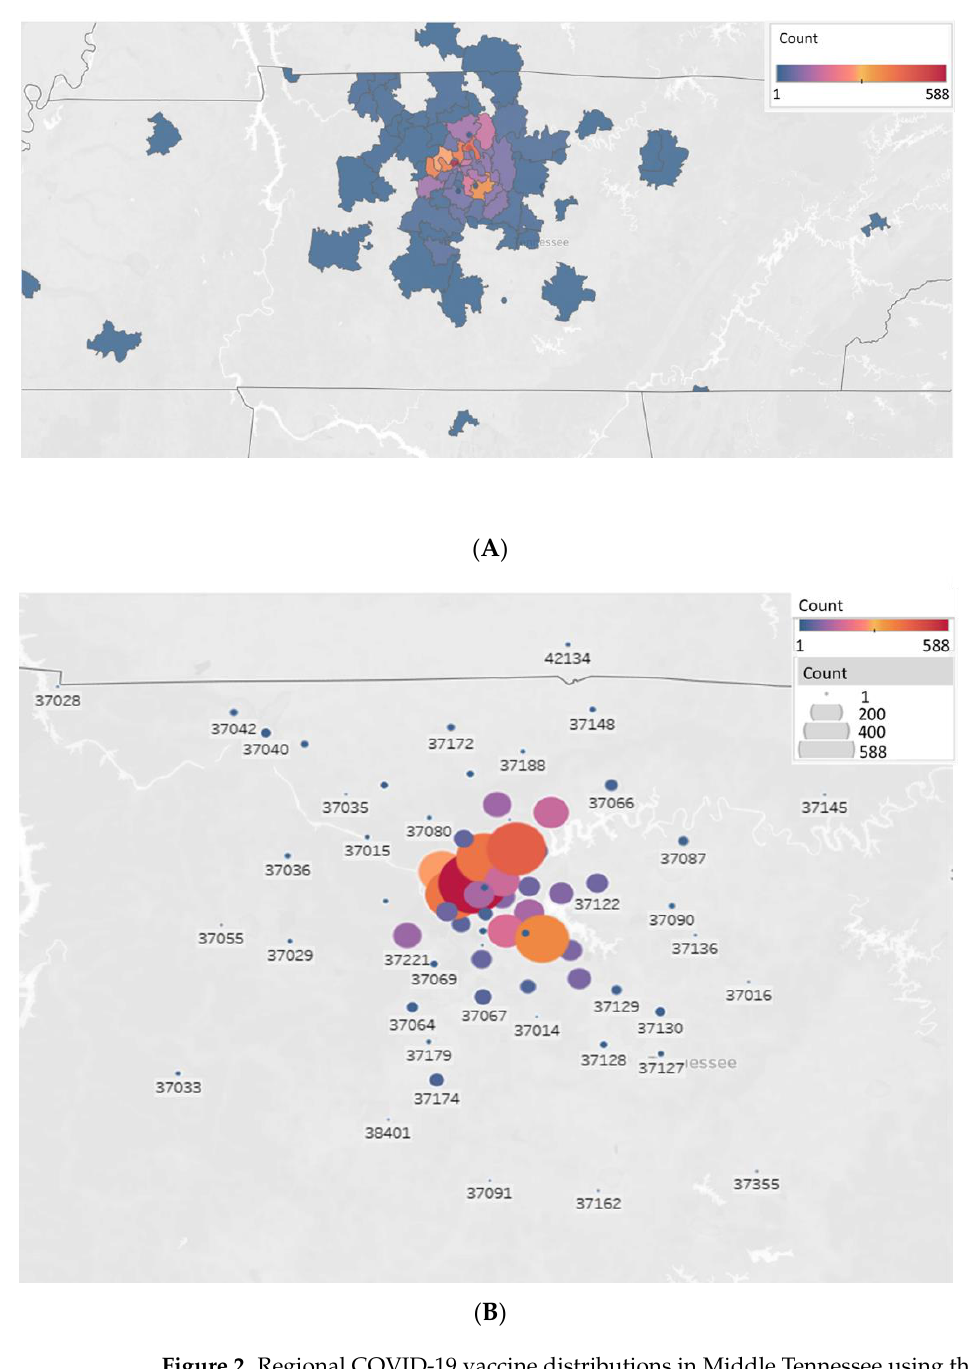
Figure 2. Regional COVID-19 vaccine distributions in Middle Tennessee using the MMC-MVP ( A ). Distribution of vaccines in Middle Tennessee by the Meharry Medical College-Mobile Vaccination Program by zip code; vaccination count represented by size and color ( B ).